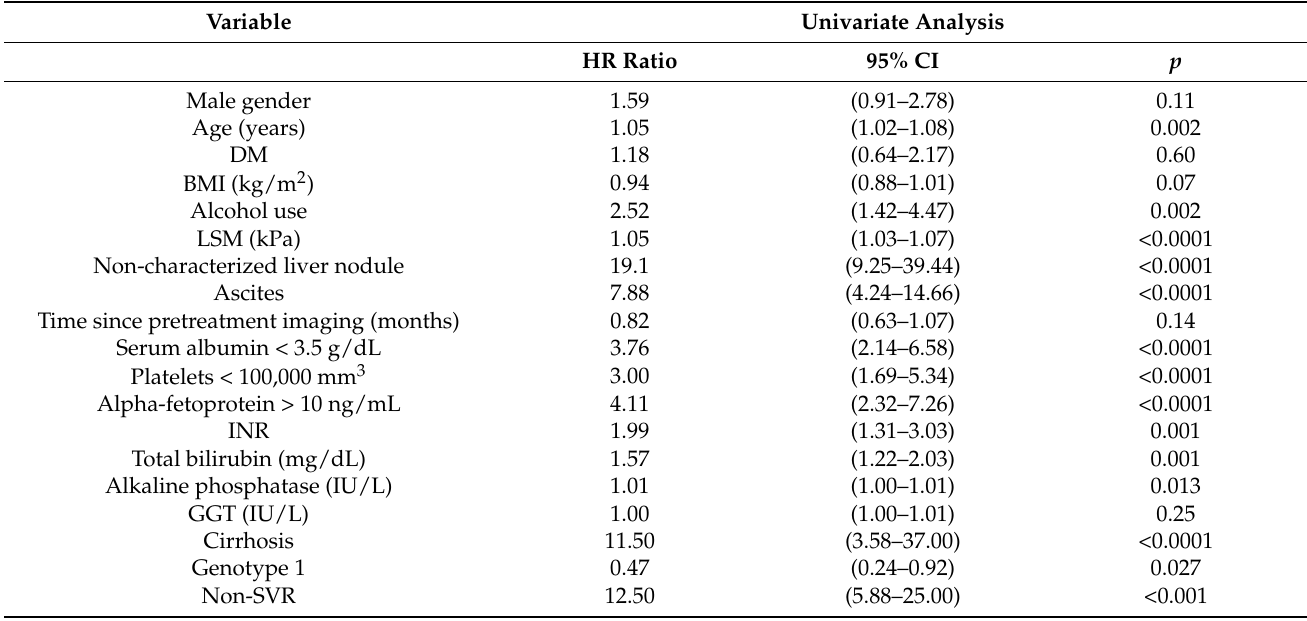
Table 2. Univariate cox proportional hazard regression analysis of variables associated with the risk of developing hepatocellular carcinoma after the start of DAA treatment (N = 1075).